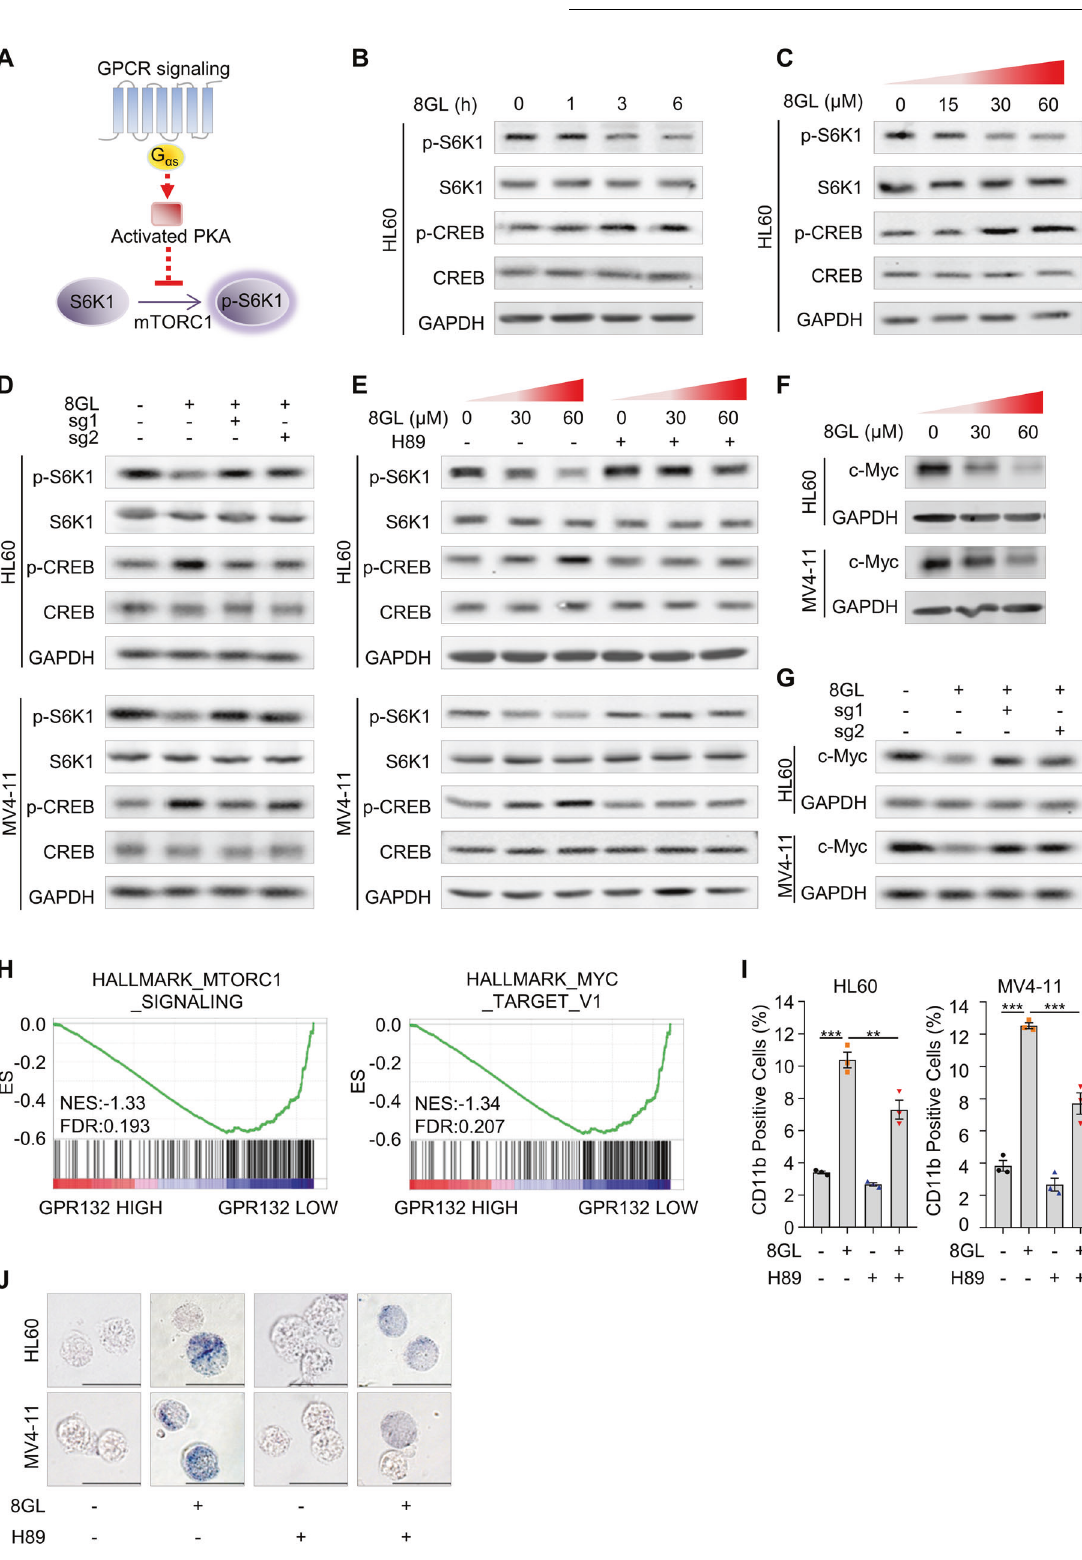
pathway plays a prominent role in the regulation of differentiation